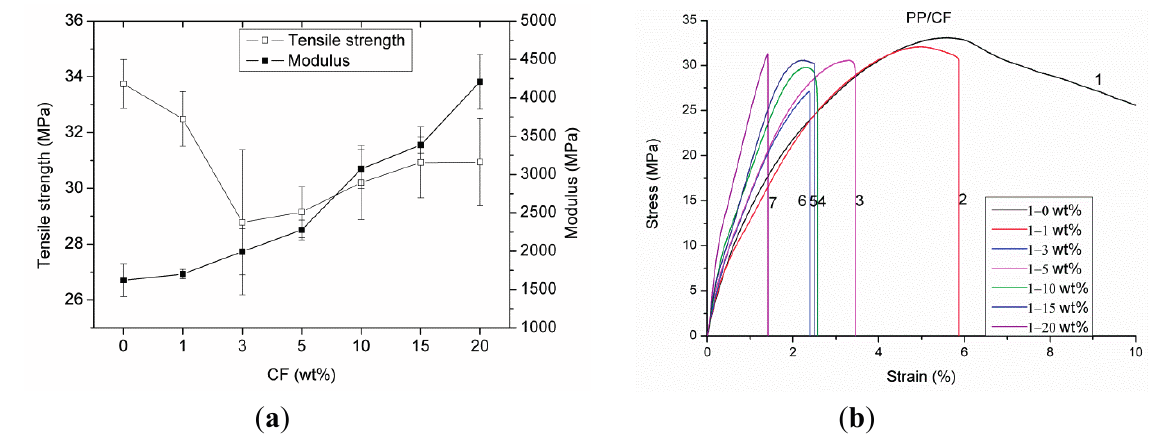
Figure 6. The tensile properties of PP/CF composites: ( a ) tensile strength and modulus and ( b ) stress-strain curve.